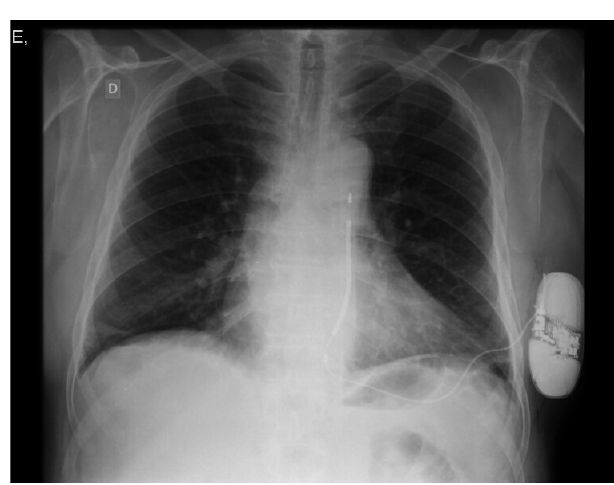
Fig. 3 - Postoperative posteroanterior (PA) chest radiograph Fig. 4 - Frequency and etiologyfor the S-ICD. HCM=hypertrophic cardiomyopathy; ICMD=dilated ischemic cardiomyopathy; CD=Chagas disease; ARVC=arrhythmogenic right ventricular cardiomyopathy; LQTS=congenital long QT;